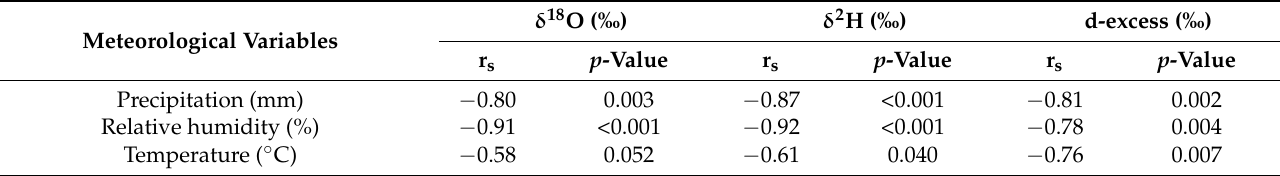
Table 2. Spearman correlation between monthly averages of meteorological variables and the isotopic signal of precipitation in S ã o Francisco Xavier, Brazil (Correlation graphical details are contained in the Supplementary Material—Figure S1). Meteorological Variables